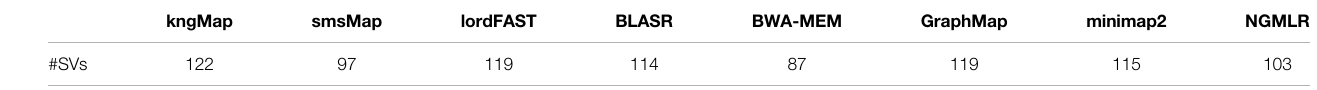
TABLE 2 | Number of mapped reads that span SV breakpoints for different mapping methods.